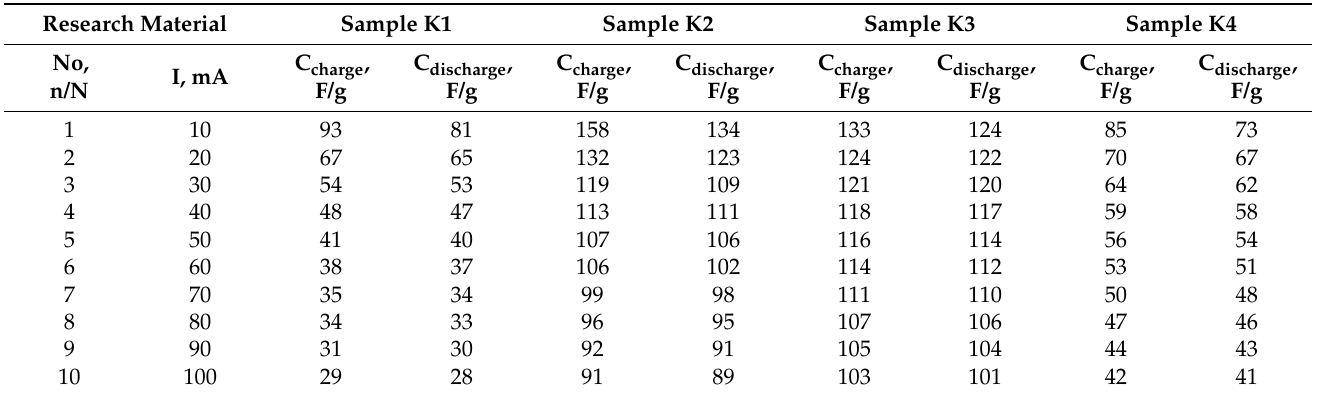
Table 4. The specific capacity of HSCs on synthesized materials obtained from galvanostatic charge/discharge curves. Research